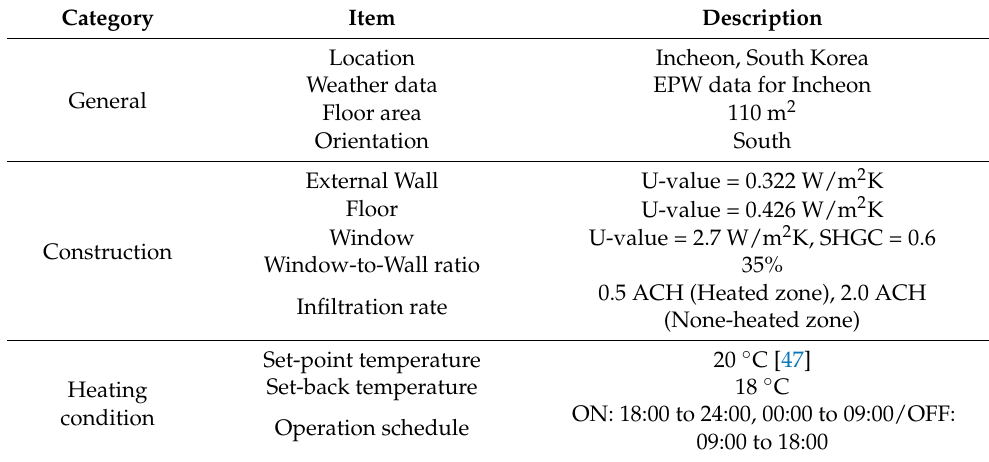
Table 4. Input parameters of TRNSYS